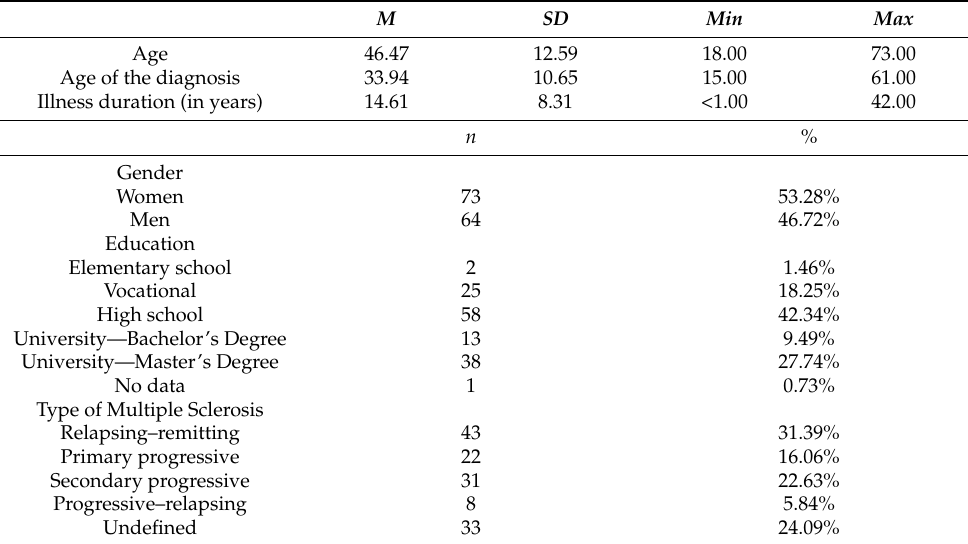
Table 1. Characteristics of the studied